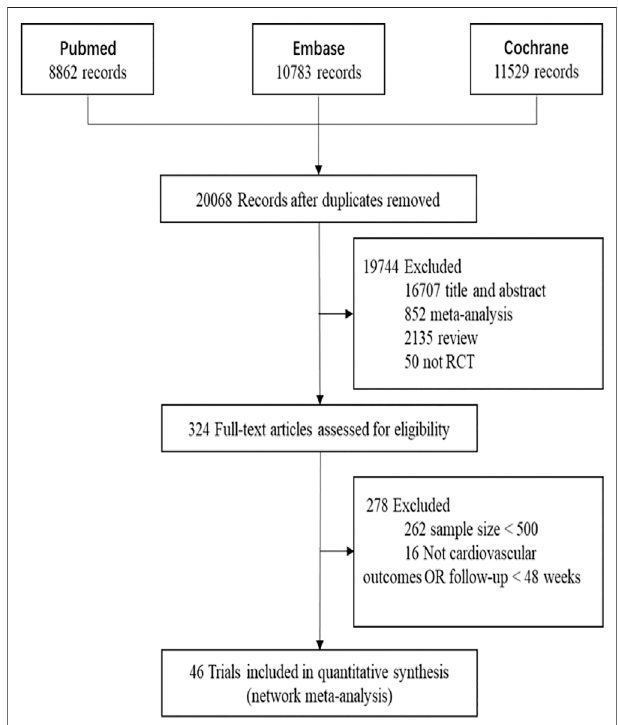
FIGURE 1 | The process of search and selection of randomized controlled trialsfornetworkmeta-analysisinthe fl owchart.RCT,randomizedcontrolledtrials.